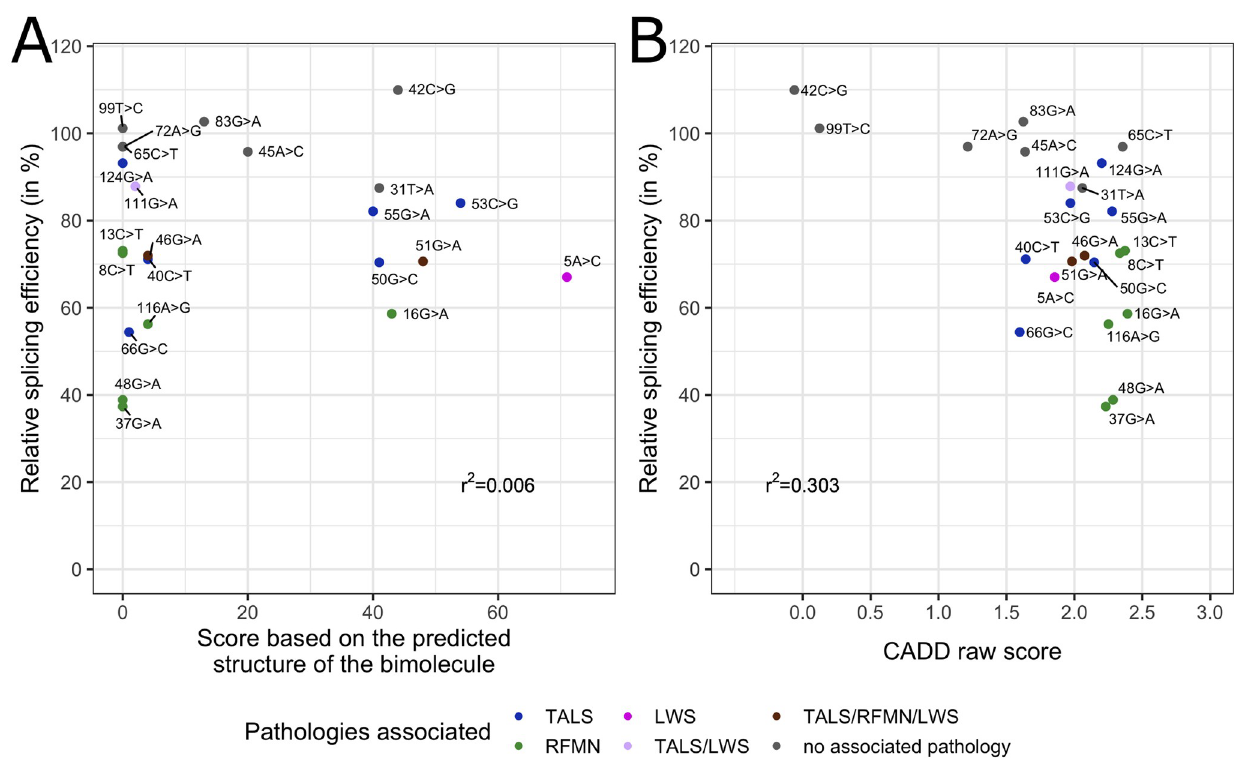
Fig 6. Splicing efficiency of the U12-type reporter intron measured after transfection of RNU4ATAC variants as a function of A . the score obtained with bioinformatic predictions of the U4atac/U6atac bimolecule structure or B . the Combined Annotation Dependent Depletion (CADD) raw score. For clarity, variants’ names were